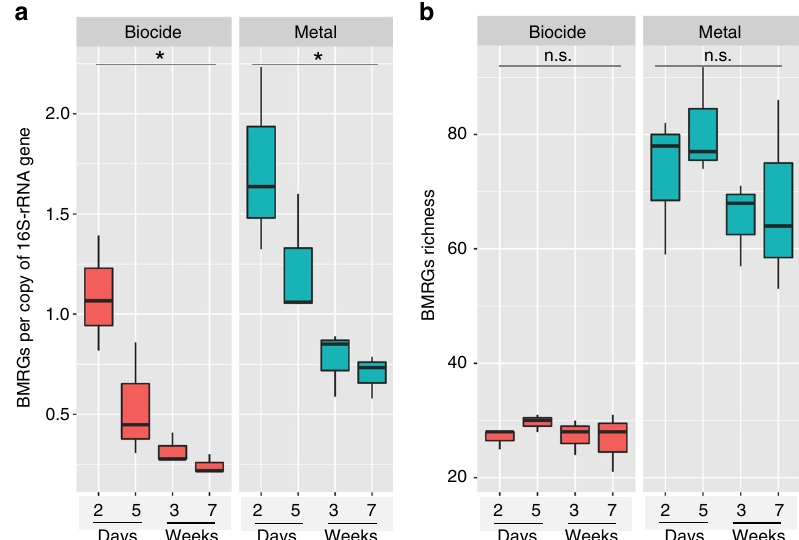
Fig. 7 The distribution of antibacterial biocide and metal resistance. a Boxplot (boxes representing IQRs with median shown in black) of the abundance of normalized BMRGs; BMRGs signi fi cantly declined over the course of sampling. b Boxplots showing the richness of dairy calves; BMRGs remained comparable over time. BMRGs data were normalized by the same method used for normalization of ARG reads (see Methods). * P < 0.05, and n.s. indicates P > 0.05 by Friedman ’ s